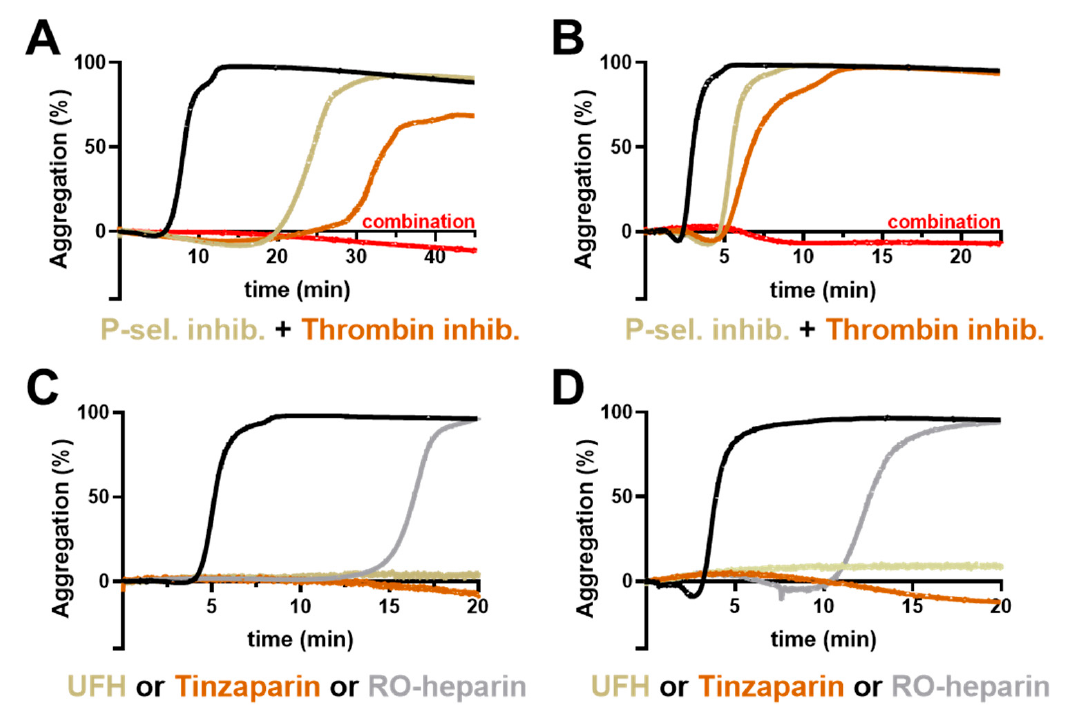
Figure 5. Impact of inhibitor combinations on platelet aggregation. Representative aggregation curves of platelets activated with 1 × 10 4 AsPC-1 ( A ) or Capan-2 ( B ) cells/mL, (black curves). In some experiments, platelets were preincubated with thrombin inhibitor Argatroban, a P-selectin inhibitor (Bimosiamose), or combination of both inhibitors, ( n = 5). Representative aggregation curves of platelets activated with 1 × 10 4 AsPC-1 ( C ) or Capan-2 ( D ) cells/mL (black curves). In some experiments, platelets were preincubated with unfractionated heparin, Tinzaparin, or RO-heparin, ( n = 5).